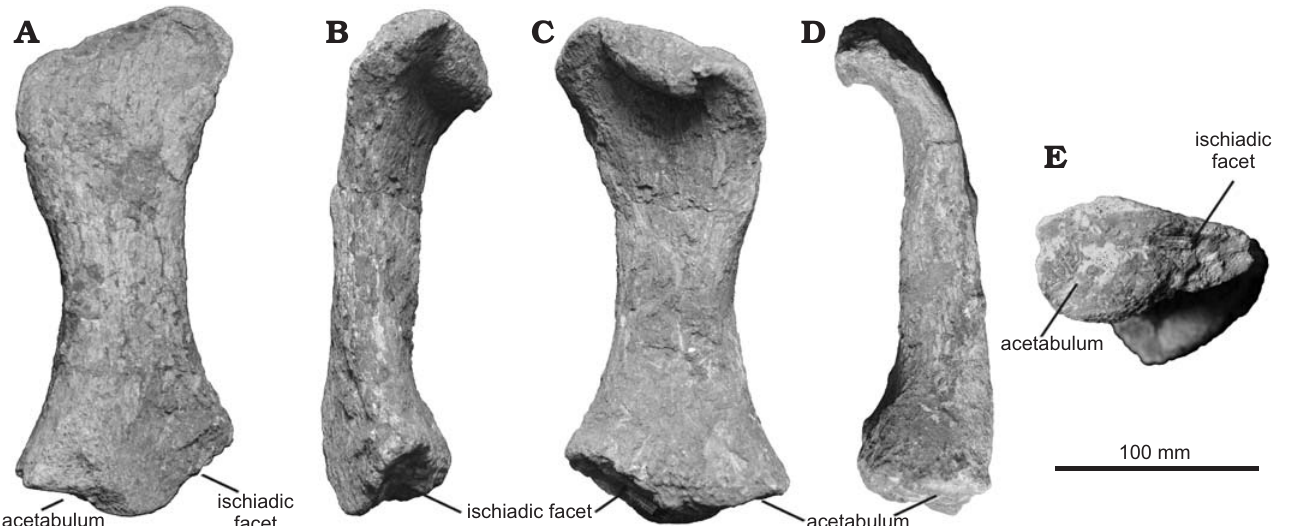
Fig. 7. Left ilium of the plesiosaur Rhomaleosauridae indet., SGM 1445-99, from the Lower Callovian Hlebnovka Formation of “Konnyi barak” ravine, Russia, in lateral ( A ), posterior ( B ), medial ( C ), anterior ( D ), and ventral ( E ) views.